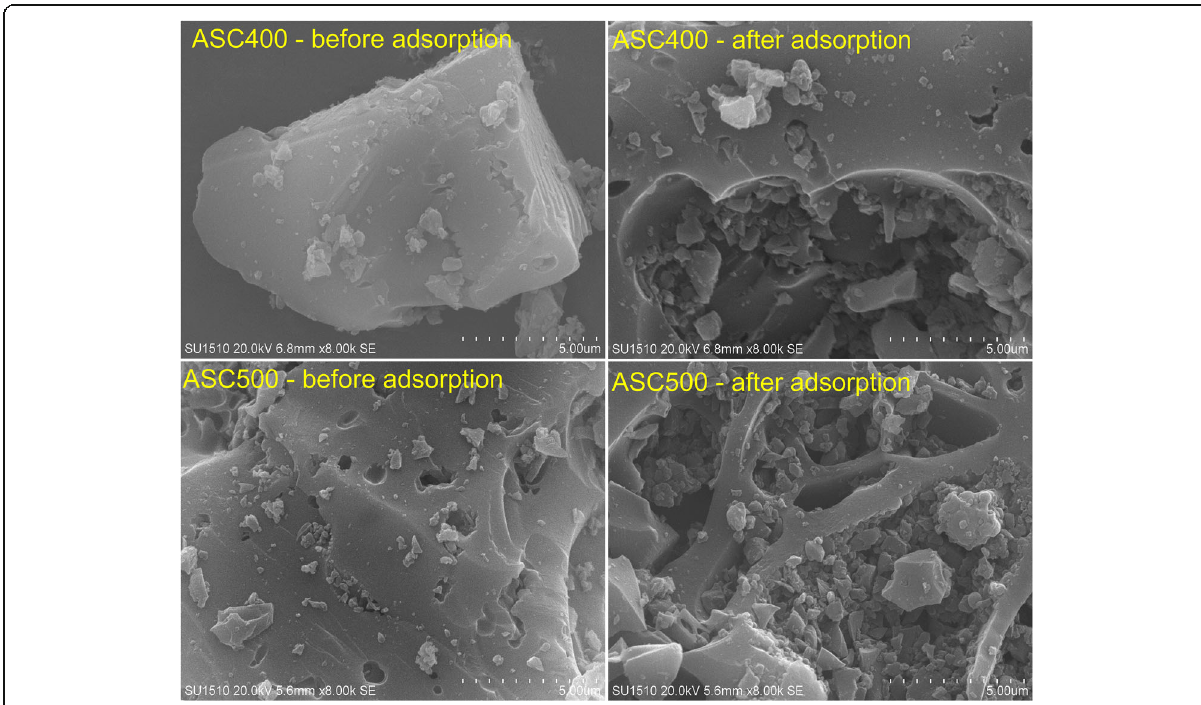
Fig. 3 SEM images of ASC400 and ASC500 before and after Cr(VI) adsorption